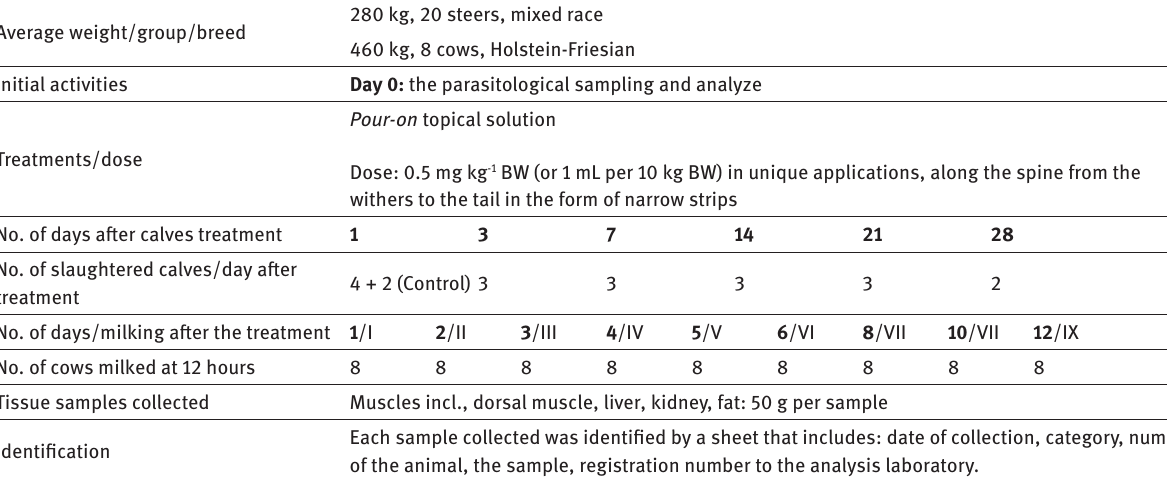
280 kg, 20 steers, mixed